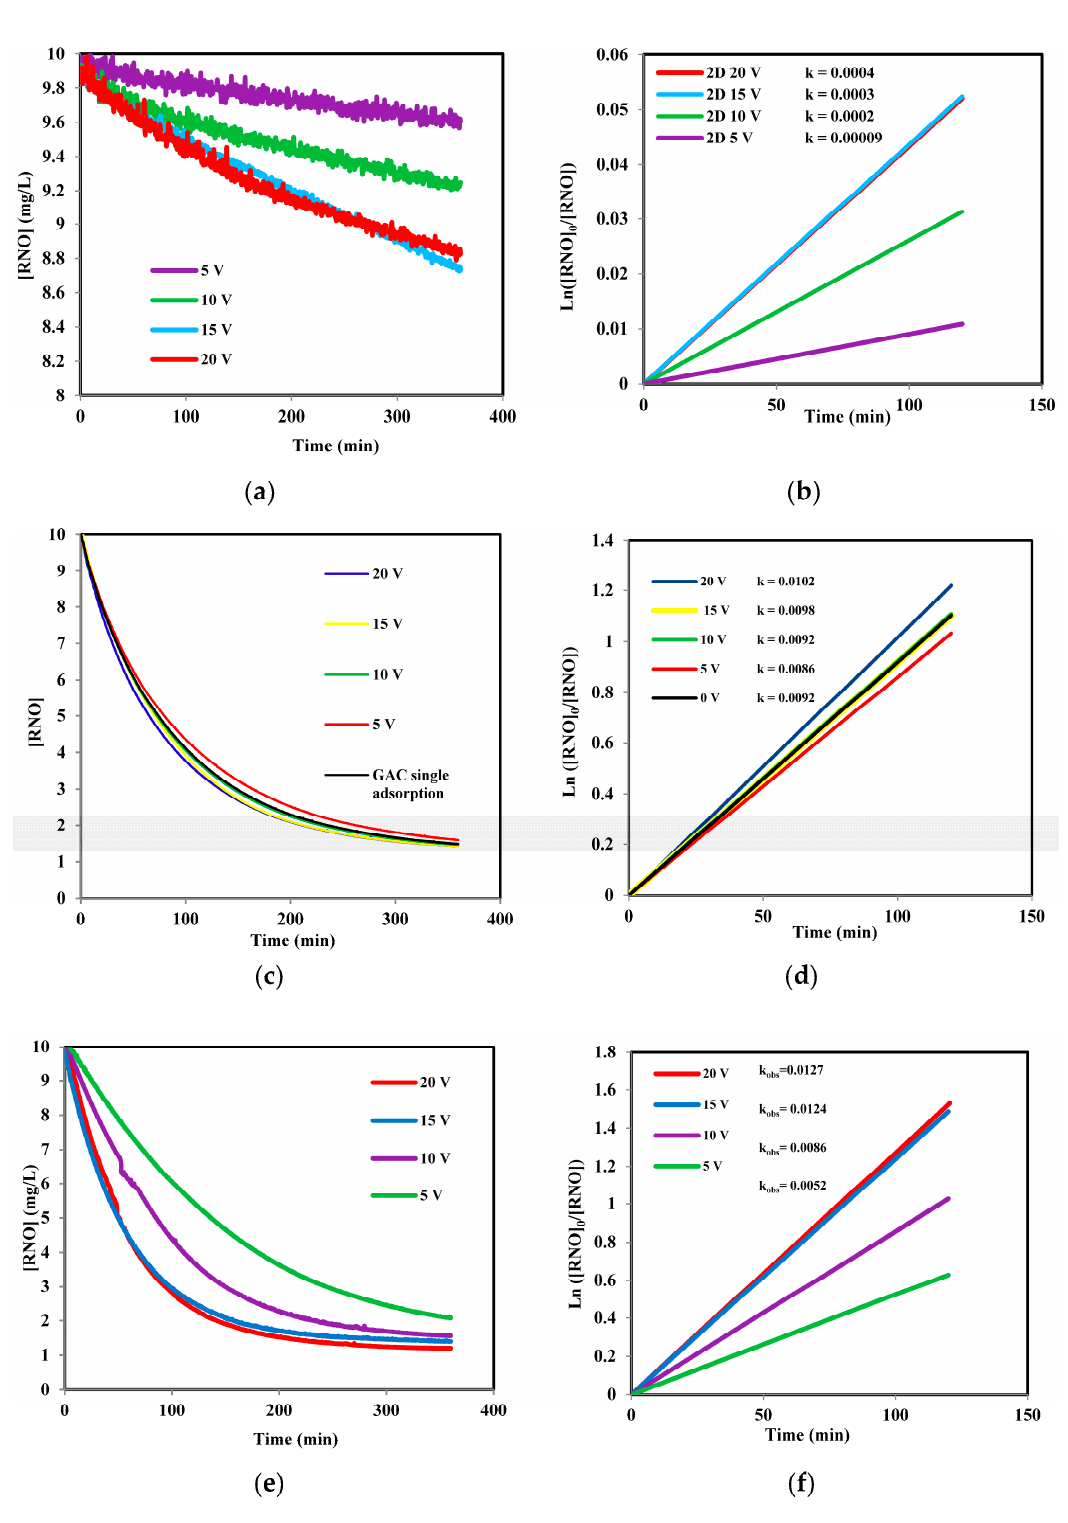
Figure 4. RNO degradation ( a , b ) in a 2D system with corresponding kinetic rate curves, ( c , d ) a 3D system using GAC as particle electrodes with corresponding kinetic rate curves, and ( e , f ) a 3D system using NCPEs as particle electrodes with corresponding kinetic rate curves.